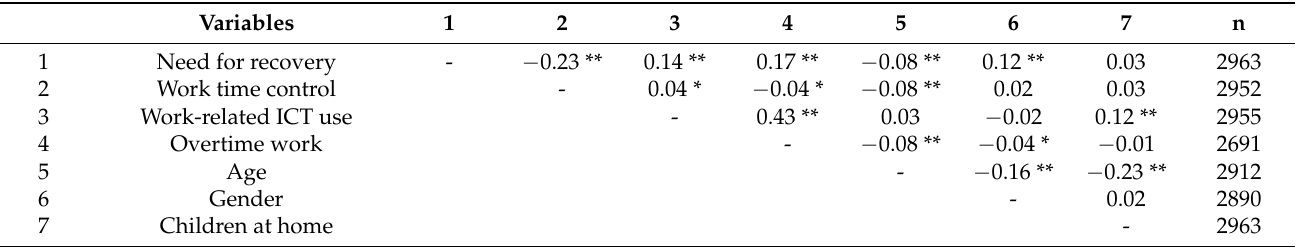
Table 2. Pearson correlations between study